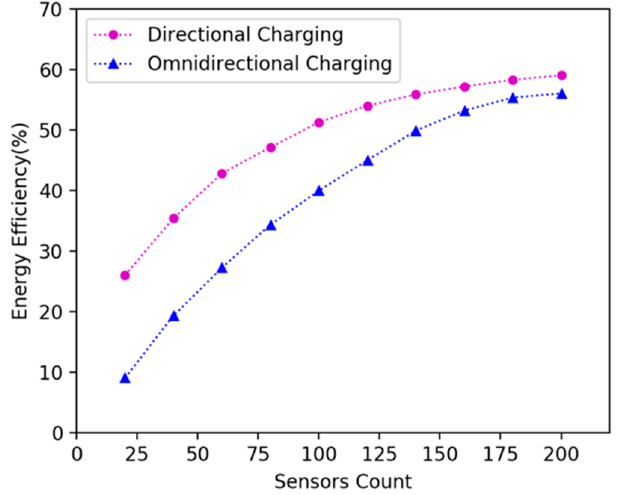
Figure 16. Energy e ffi ciency of the DCV and omnidirectional charging vehicle in 25 × 25 m 2